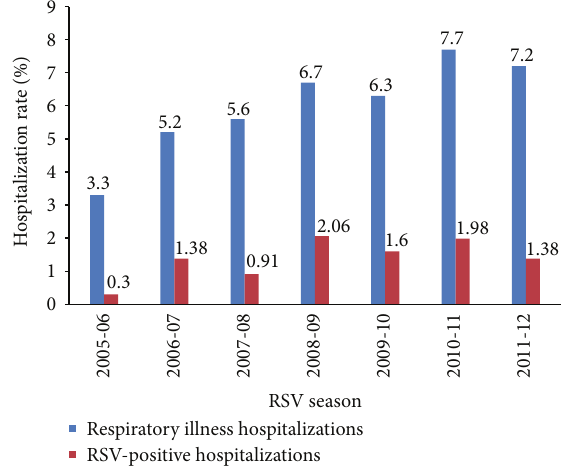
Figure 3: Hospitalizations for respiratory-related illness and RSV- positive infection